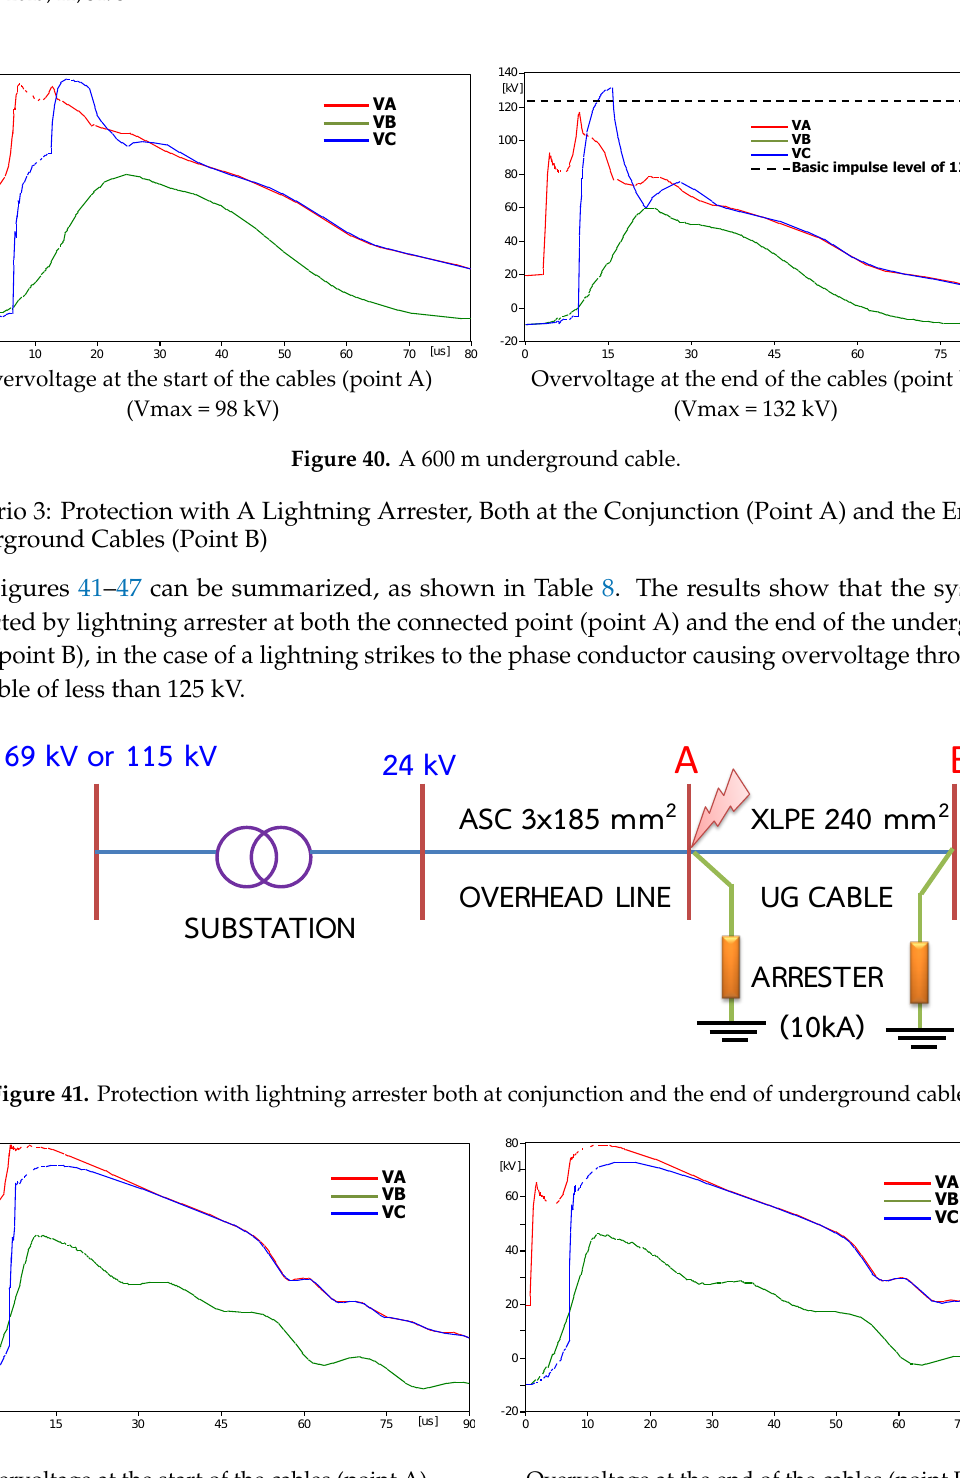
Figure 39. A 500 m underground cable.